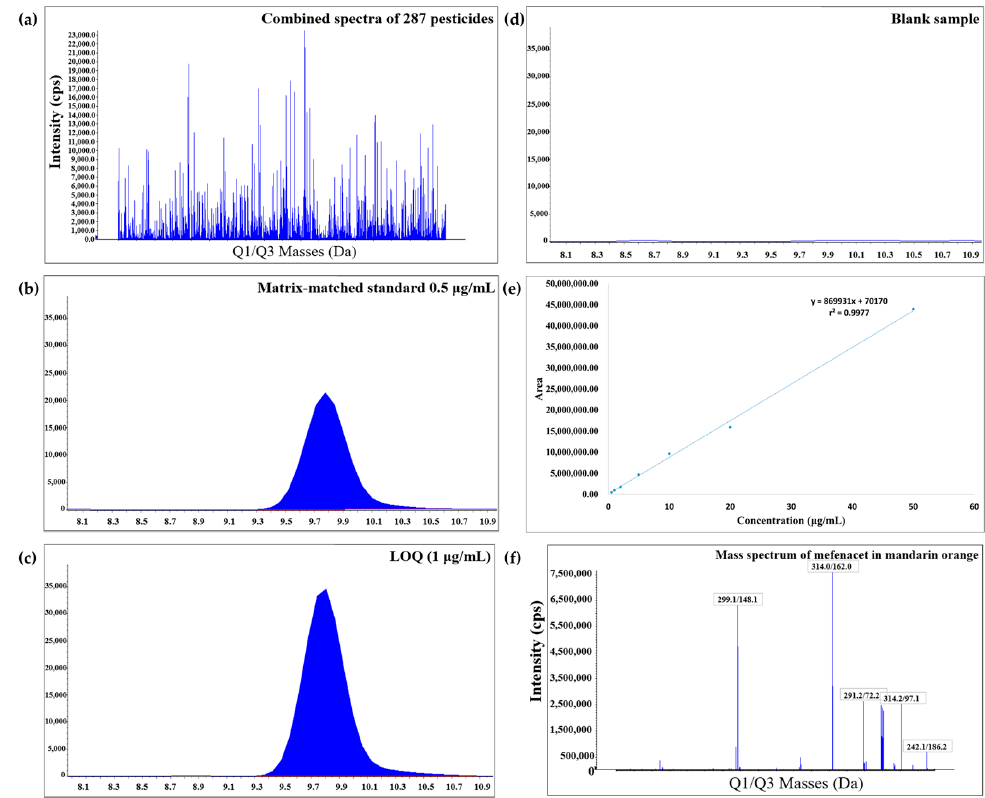
Figure 5. ( a ) Combined spectra of 287 pesticides. ( b ) Chromatogram of the lowest matrix-matched standard solution. ( c ) Chromatogram of the limit of quantification (LOQ). ( d ) Chromatogram of the blank sample. ( e ) Matrix-matched calibration curve. ( f ) Mass spectrum of mefenacet in mandarin orange.